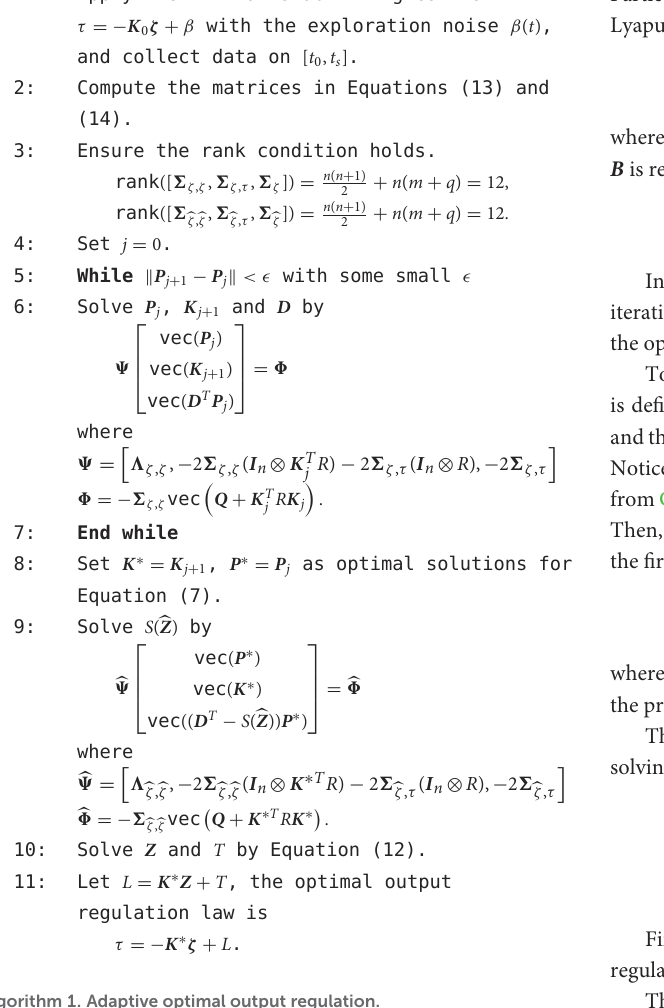
Algorithm 1. Adaptive optimal output